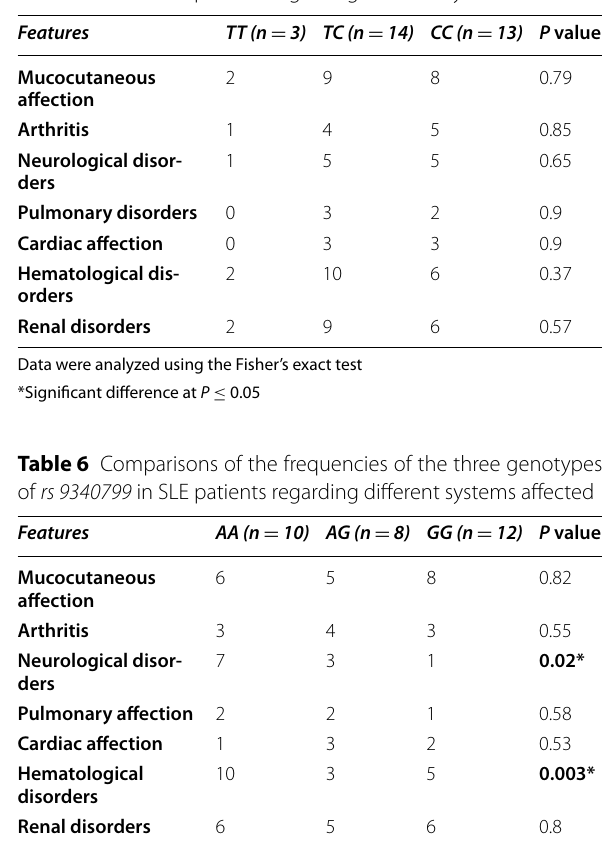
of rs 2234693 in SLE patients regarding different systems affected